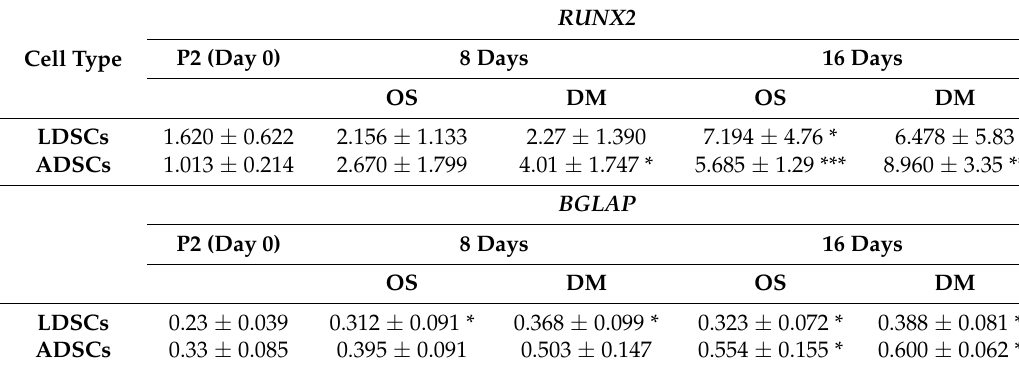
Table 2. Relative expression of RUNX2 and BGLAP in LDSCs and ADSCs at days 8 and 16 of osteogenic differentiation, normalized to GAPDH and compared to the cells at P2 (day 0). Results are expressed as mean values ± SD. Asterisks represent statistical significance compared to P2 (day